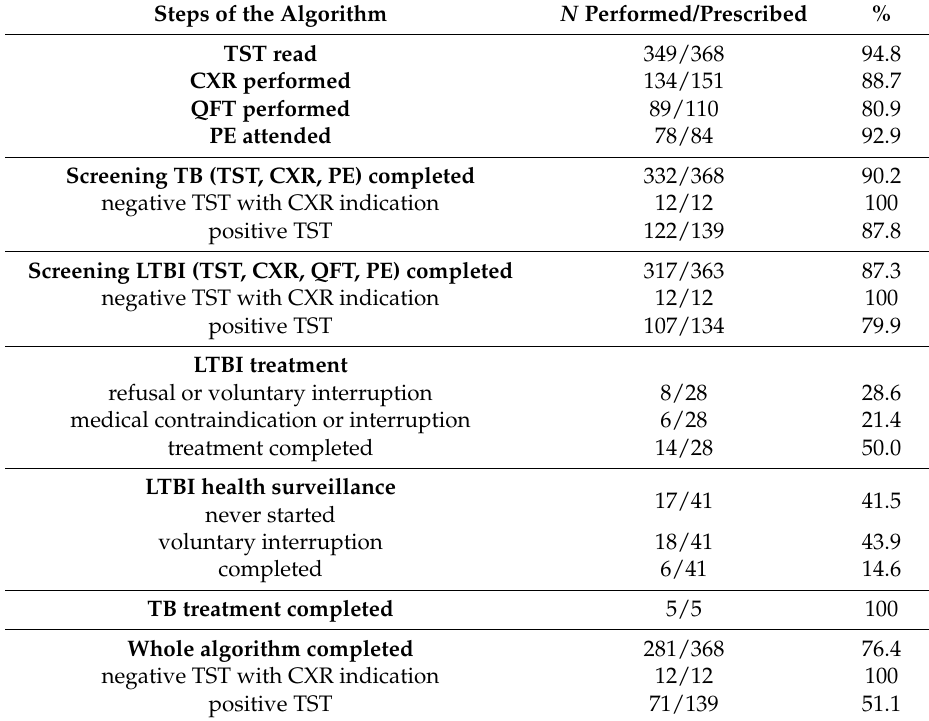
Table 1. Compliance with the different steps of the algorithm and treatment